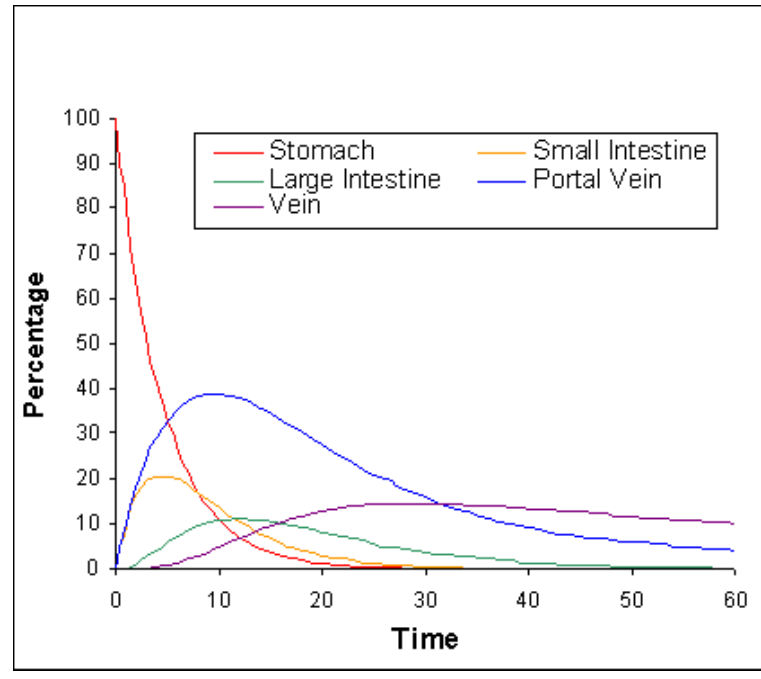
FIGURE 7. Simulation showing absorption of drug from different parts of the gastrointestinal